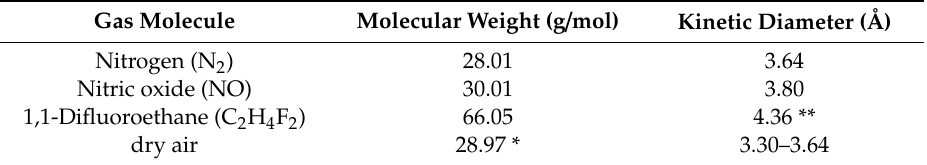
Table 1. Gas characteristics.